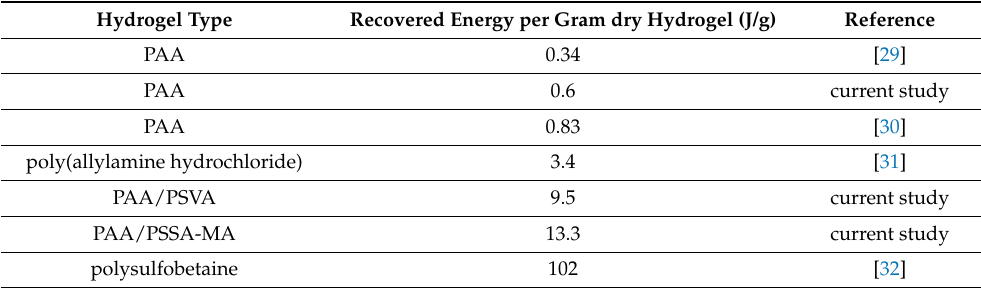
Figure 10. The maximum recovered energy per gram of dried hydrogel for the different hydrogels. Table 2. Comparison of the energy recovered from different